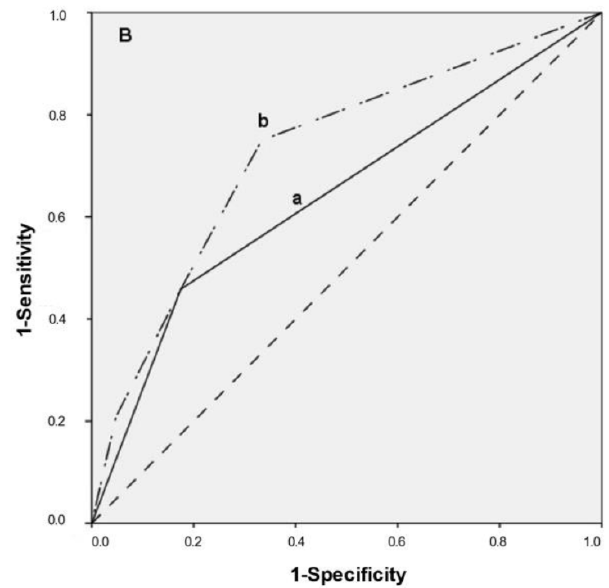
Figure 2. ( A ) Receiver Operating Characteristic-curve (ROC) for histopathological diagnosis (black line a; AUC = 0.64) and in combination with PAN-FISH ≥ 10% (upper dotted line b), AUC = 0.75, optimal sensitivity 71%, specificity 70%. ( B ) Receiver Operating Characteristic-curve (ROC) for histopathological diagnosis only (black line a) and in combination with CR-FISH (upper dotted line b), AUC = 0.73, optimal sensitivity 75%, specificity 66%.